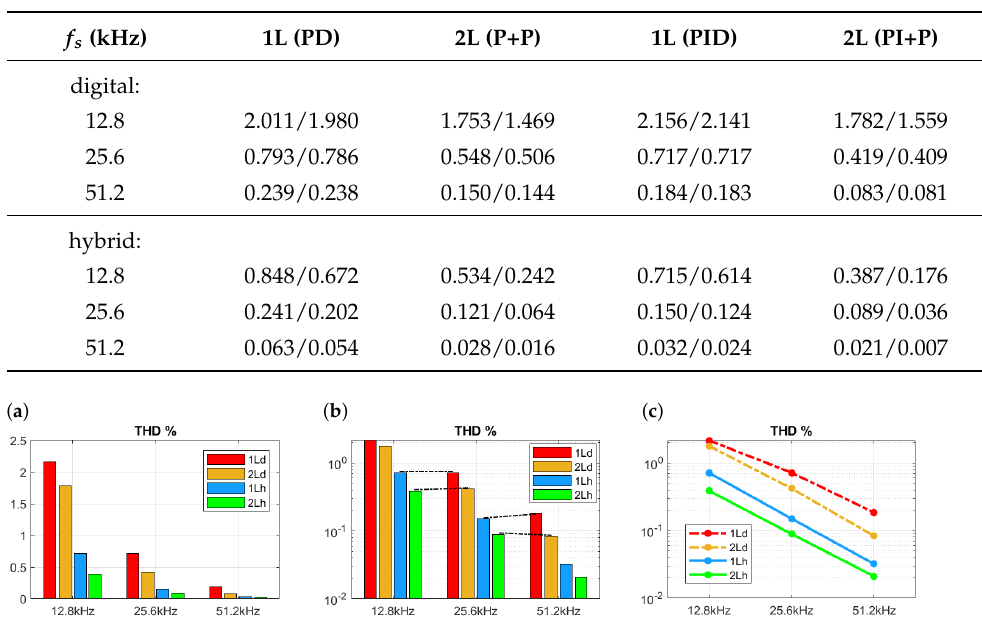
Table 4. Summary of THD values for the PWM modulator and QCT method, written as PWM/QCT, for the RC rectifier load. The difference between both components is due mainly to the ripple caused by the carrier signal.